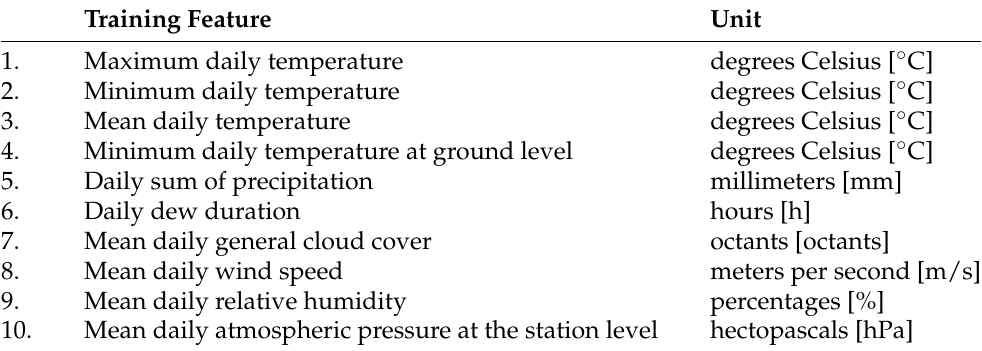
Table 2. Features of the training dataset (inputs for the MLP model).